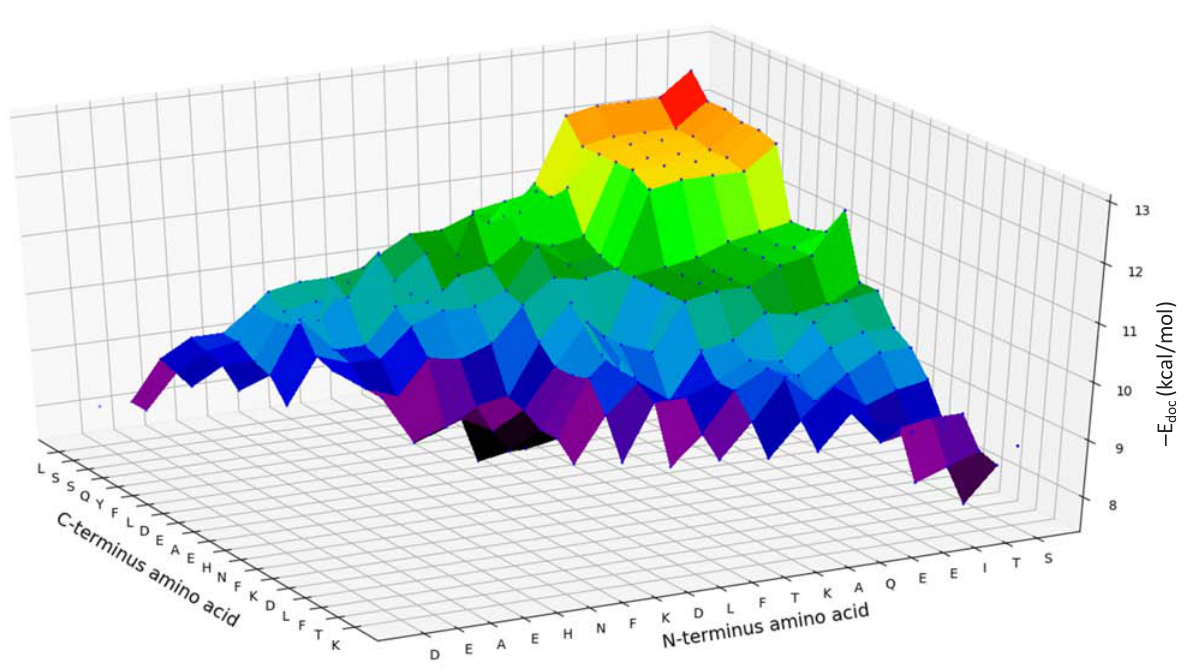
Fig. 3. Docking energy landscape for binding of peptides with the receptor binding site on SARS­CoV­2 spike protein S1. Peptides were derived from the ACE2 sequence 19–45, STIEEQAKTFLDKFNHEAEDLFYQSSL, through systematic truncation from the N­terminus and C­terminus, and the end amino acids of peptides are shown in the